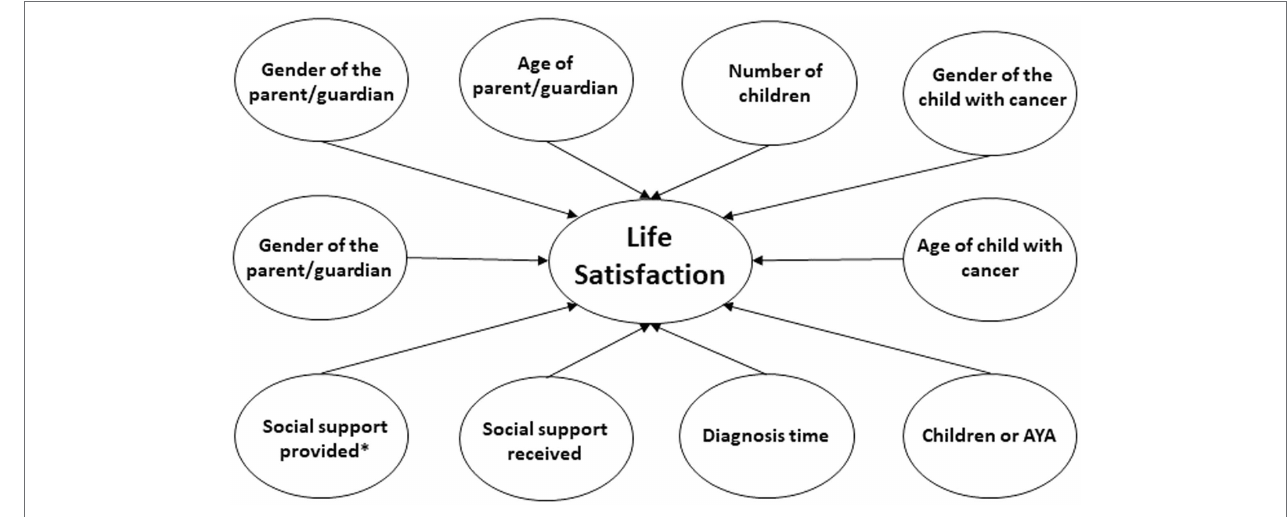
FIGURE 2 | Life Satisfaction model.